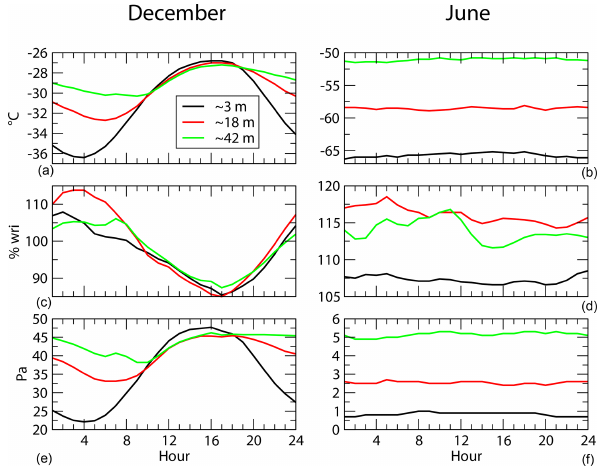
Figure 8. Mean 24h cycle of temperature (a, b) , RHi (c, d) and PPW (e, f) in December (a, c, e) and June (b, d, f) averaged over 2018–2020. Time is local time (UTC + 8h).